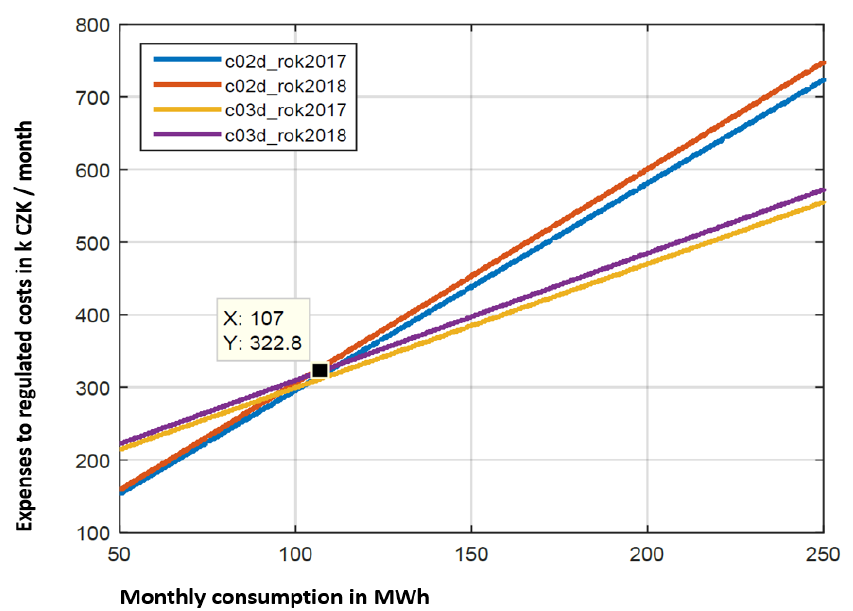
Figure 2: Dependence of monthly costs for regulated payments on consumption for prices from 2017 and 2018 and for tariffs C02D and C03D. (Source: authors with the use of